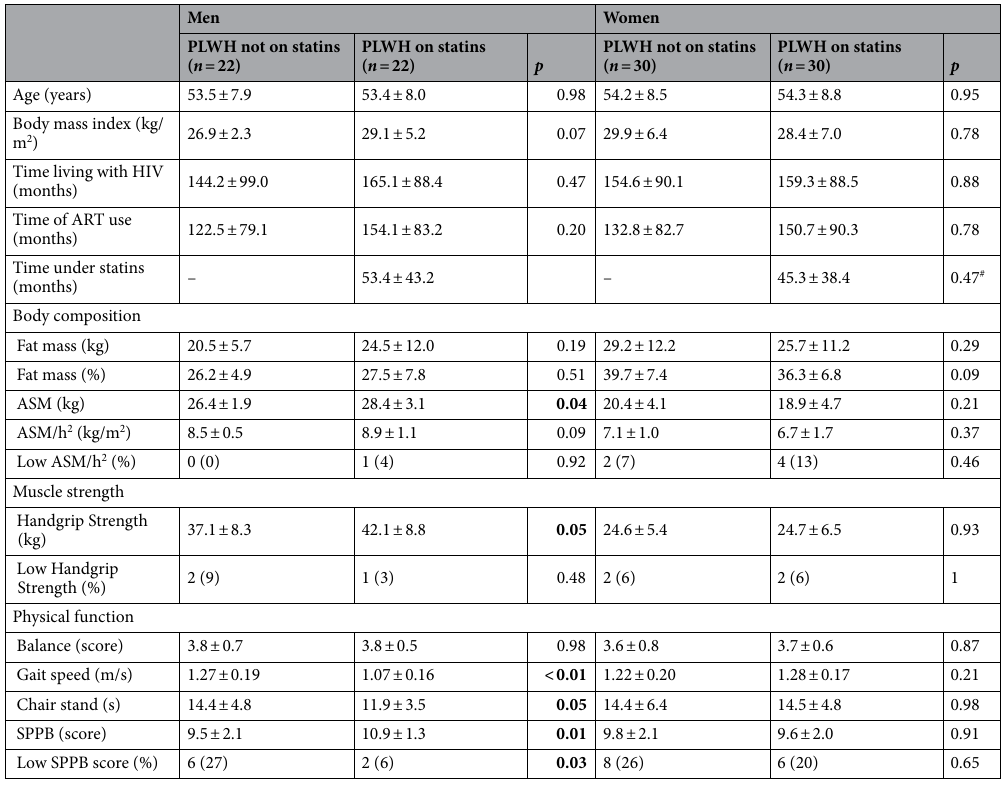
Table 2. Sarcopenia defining parameters in men and women living with HIV on and not on statins. Values in the table are mean ± standard deviation when variables are continuous; and number and (%) when variables are categories. Continuous variables are expressed as mean ± standard deviation, and categorical variables are expressed as absolute (relative) values. Low values for ASM/h 2 , handgrip strength, and SPPB were determined according to Cruz-Jentoft et al . 19 . PLWH people living with HIV, ART antiretroviral therapy, ASM appendicular skeletal muscle mass, ASM/h 2 ASM index, SPPB short physical performance battery. # Comparison between men and women on statins. Significant values are in bold.